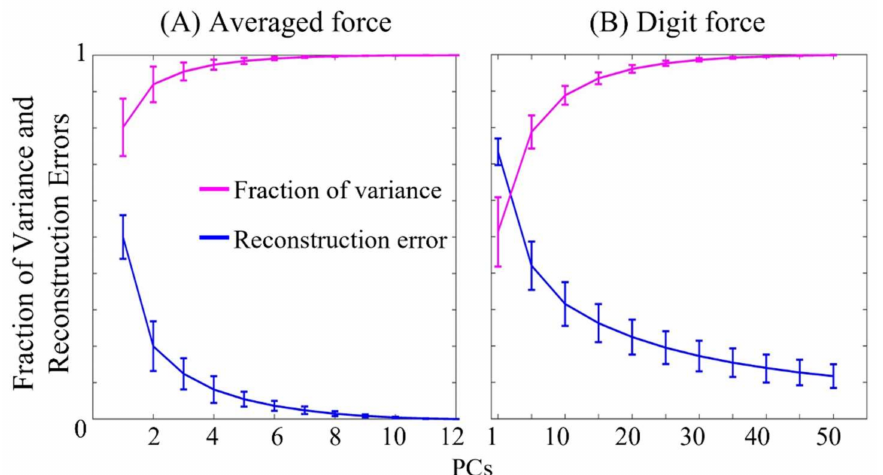
Figure 2. The fraction of the variance accounted for and the reconstruction errors were calculated using the top-order synergies. The mean and standard deviation was calculated across ten subjects. ( A ) 12 synergies were extracted from the averaged force vectors and ( B ) 361 synergies extracted from spatial force maps (only the first 50 synergies) are shown here.